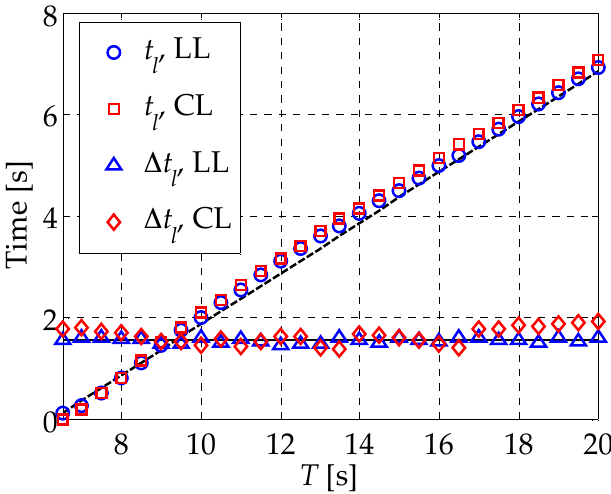
Figure 8. Optimal latching duration t l and optimal unlatching lead time Δ t l as functions of the wave period for different load types. The black solid and dash lines are the asymptotical lines of t l and Δ t l , respectively.